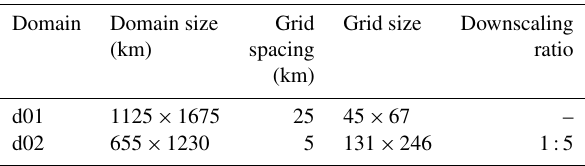
Table 2. The configurations of the WRF model for two nested do-